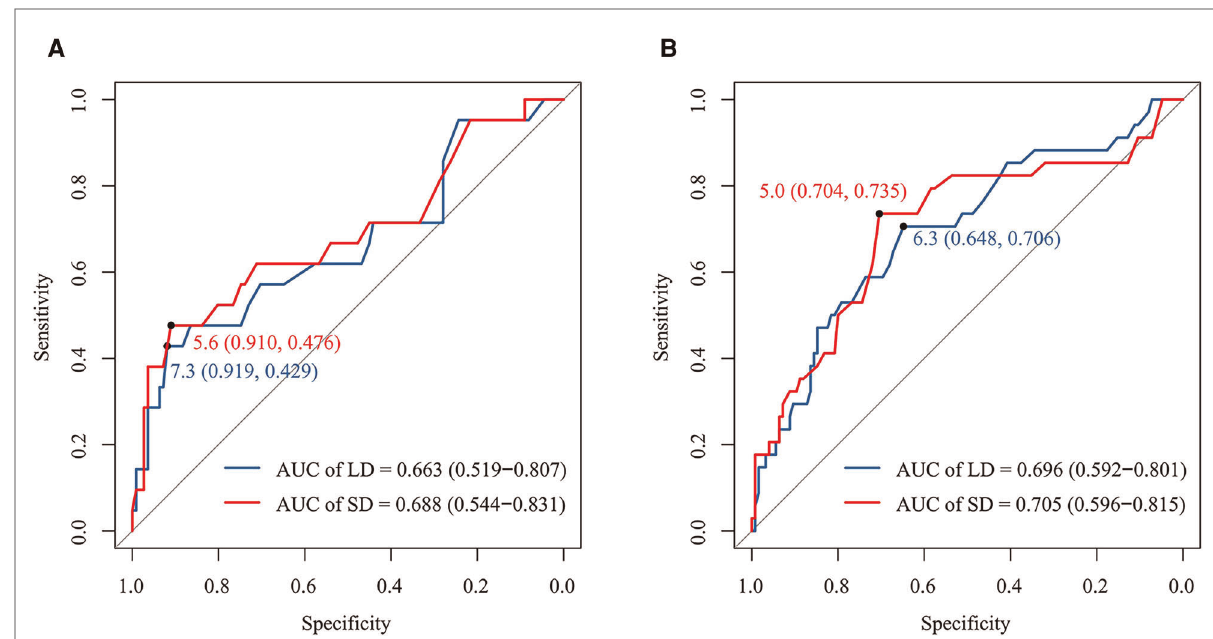
FIGURE 2 The receiver operator characteristic curves for the LD and SD of RLN LN in the left and right cohorts, respectively. The AUCs of the LD and SD of left RLN LN were 0.663 (95% CI, 0.519 – 0.807) and 0.688 (95% CI, 0.544-0.831), respectively. The optimal thresholds of the LD and SD of left RLN LN for RLN LNM were at 7.3 mm (sensitivity and speci fi city: 42.9% and 91.9%) and 5.6 mm (sensitivity and speci fi city: 47.6% and 91.0%) ( A ). The AUCs of the LD and SD of right RLN LN were 0.696 (95% CI, 0.592 – 0.801) and 0.705 (95% CI, 0.596 – 0.815), respectively. The optimal thresholds of the LD and SD of right RLN LN for RLN LNM were at 6.3 mm (sensitivity and speci fi city: 70.6% and 64.8%) and 5.0 mm (sensitivity and speci fi city: 73.5% and 70.4%) ( B ). LD, long diameter; SD, short diameter; AUC, the area under the curve; RLN LNs, recurrent laryngeal nerve lymph